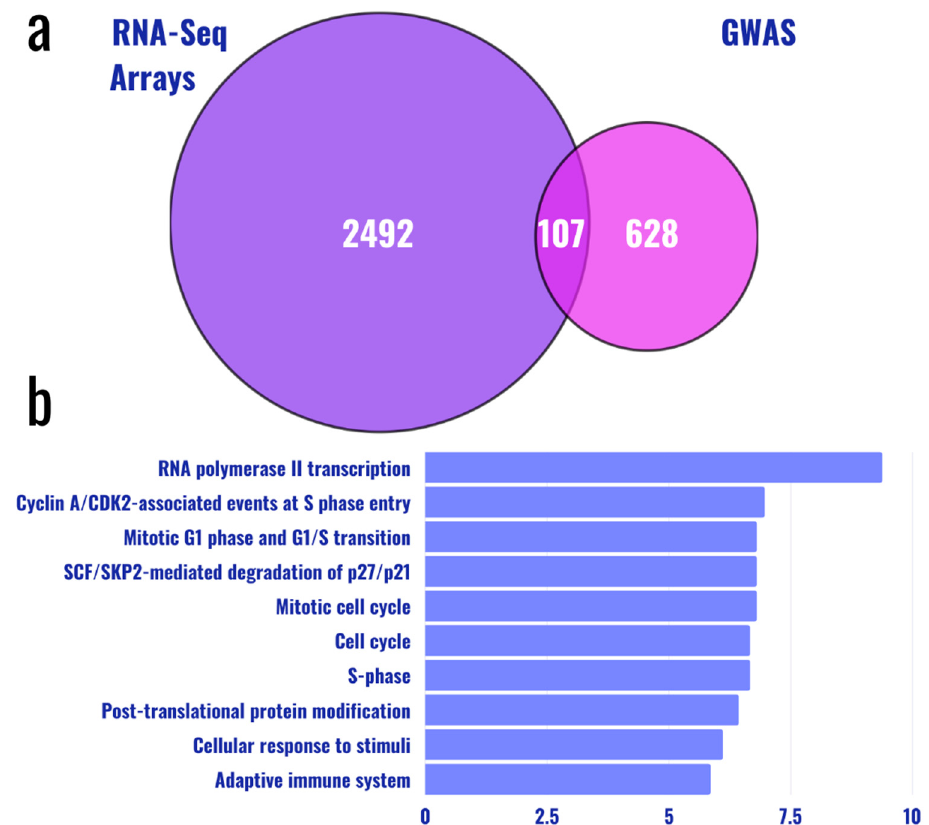
Figure 2. ( a ) Venn diagram showing the overlap between genes at significant GWAS loci for T2D and DEGs identified using RNA-seq and arrays in T2D patients; ( b ) A bar plot showing false discovery rate-adjusted enrichment p -values for the top 10 gene sets with a significant enrichment among 107 T2D DEGs identified by both transcriptomic studies and GWAS.